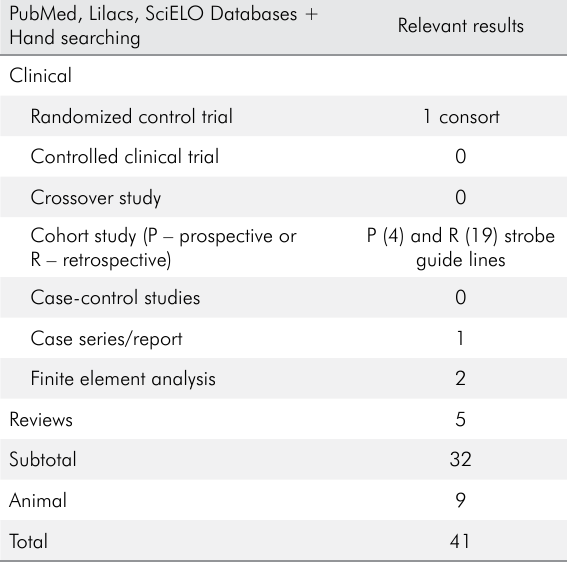
Table 2. Relevant results, sorted by study design and split into clinical and/or animal